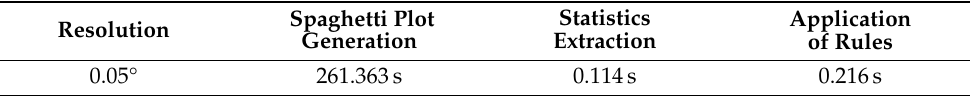
Table 2. Times required for each step of the classifier at different resolutions, for the analysis of an area of 1° × 1° for 15 days. All computations were performed on a processor Intel® Core™ i5-8250U @ 1.60 GHz with 8 GB